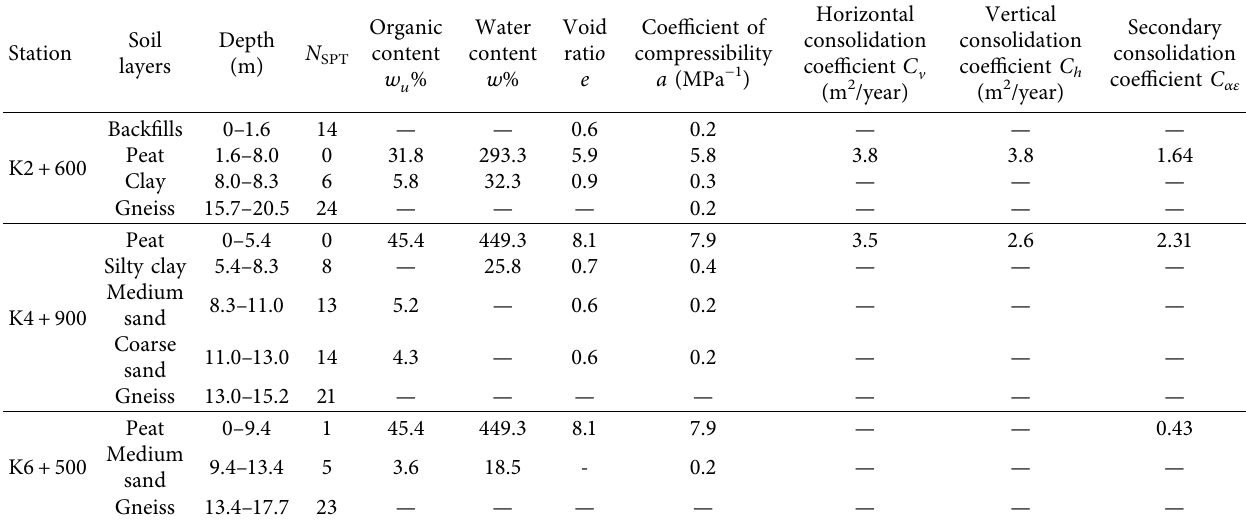
Table 2: Physical and mechanical properties of